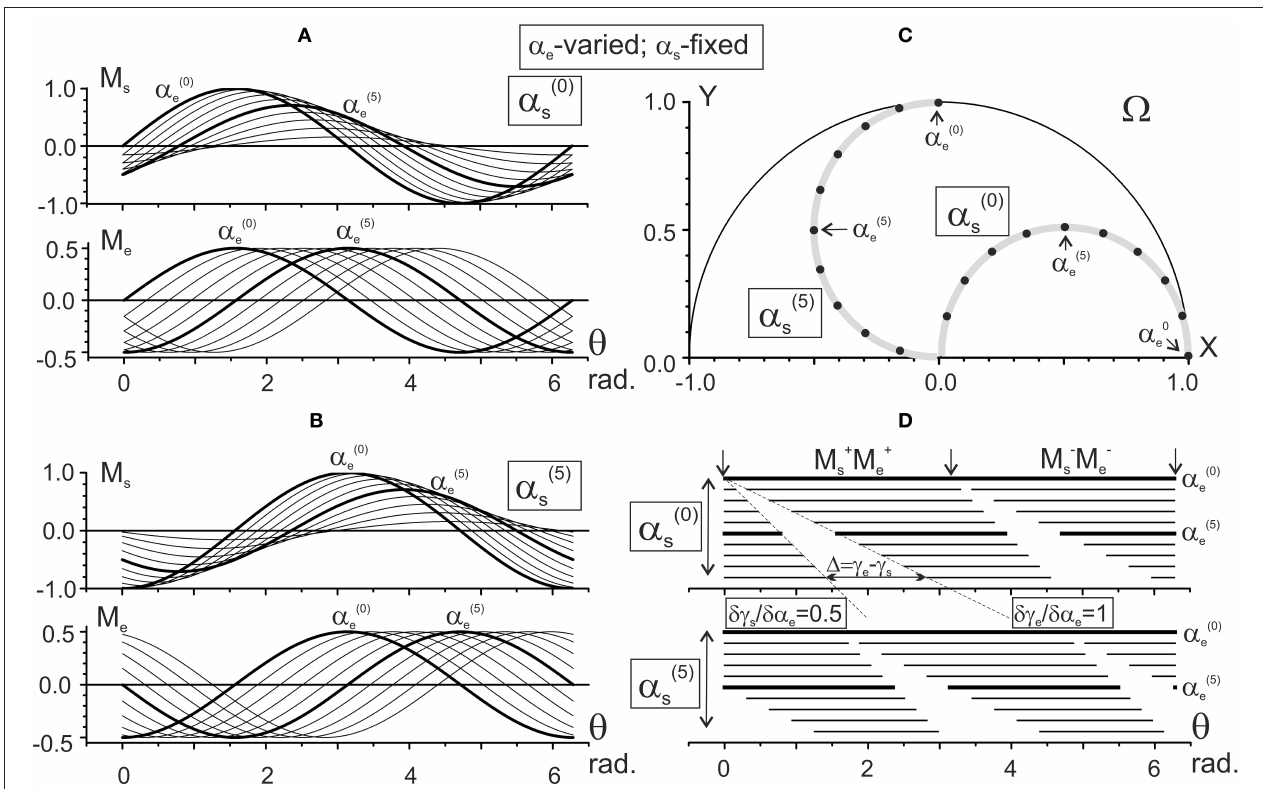
FIGURE 5 | Results of the numerical simulation of the joint torques M s , M e (A,B) for different positions of the subject’s hand in the working space (cid:127) (C) . Scheme of the data presentation coincides with that in Figure 4 ; two sets of the torques with fixation of the shoulder joint angles α (0) s and α (5) s are considered The torques M s and M e are defined by Equation (9) using the characteristic angles presented in Figure 2B . Thicker lines highlight the torque traces for the elbow joint angles α (0) e and α (5) e . Horizontal lines in (D) mark phases of the sign coincidence of the shoulder and elbow torques. Other designations are similar to those in Figure 4